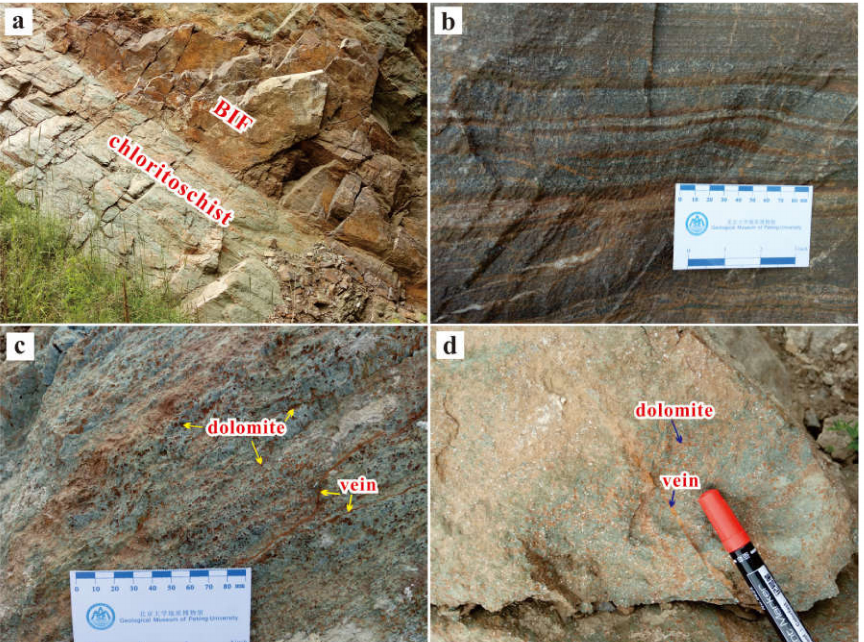
Figure 2. Photographs of the outcrop at Kangjiagou, Wutai Complex. ( a ) BIF overlies the chlorite schist. ( b ) BIF with stratifications. ( c ) Chlorite schist contains voluminous coarse-grained crystals and thin veins of dolomite. ( d ) Chlorite schist with both dolomitization and muscovitization (the scattered small white flakes).